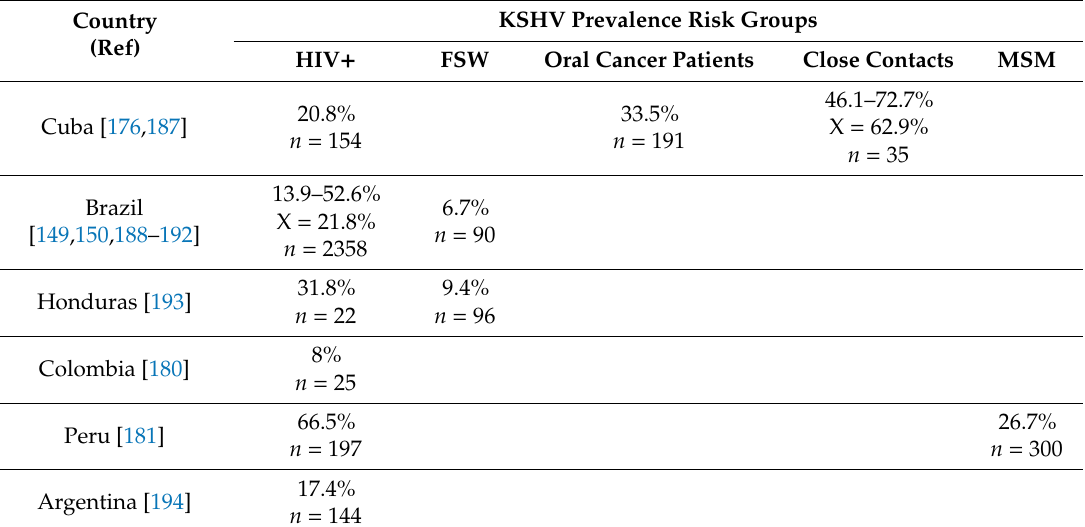
Table 3. KSHV in risk